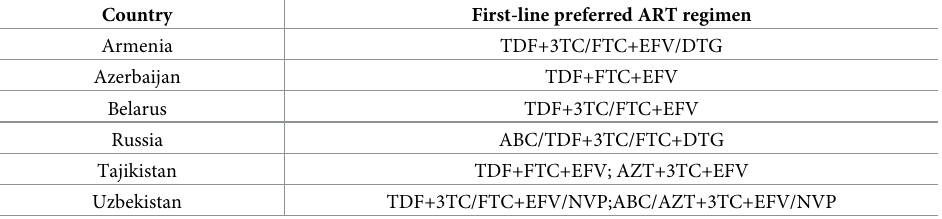
Table 2. ART profiles in the studied countries in